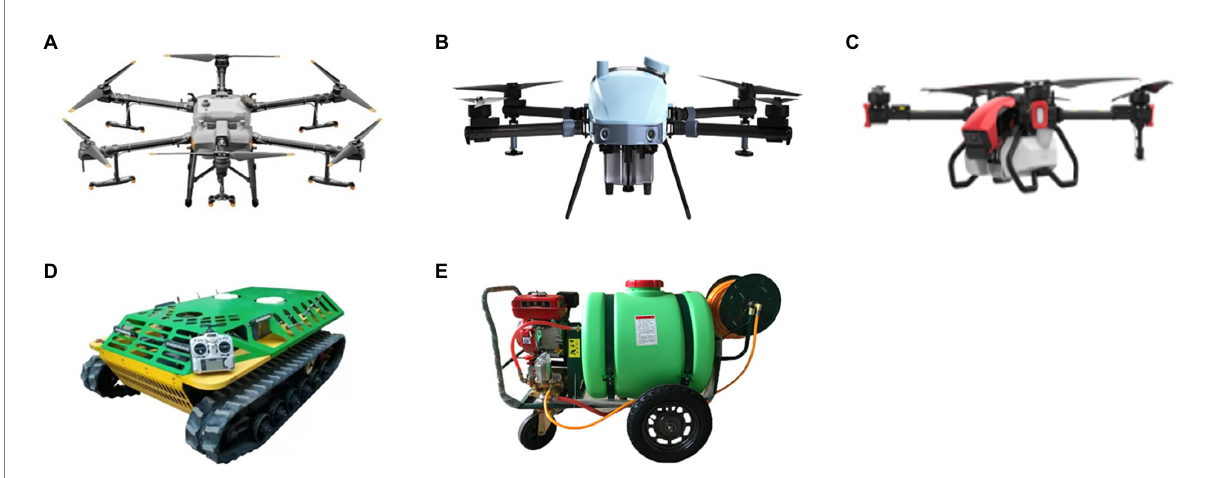
TABLE 1 Equipment and application parameters of unmanned aircraft vehicles (UAV), unmanned ground vehicle (UGV) and conventional manual spray guns (CONV) used in the trials. Parameter UAV-1 UAV-2 Tank capacity